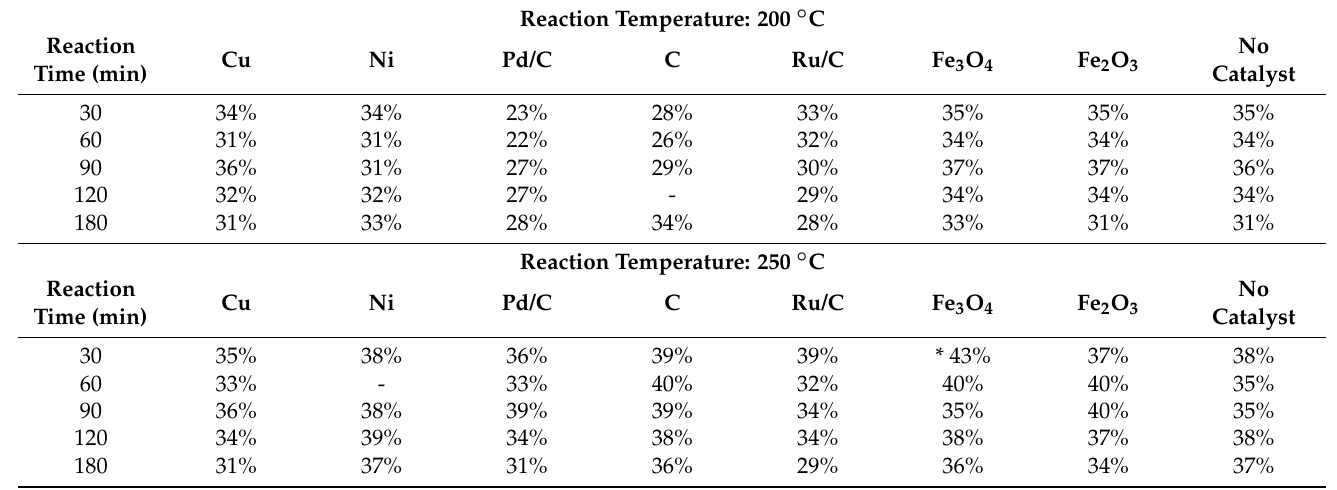
Table 3. Yields of lactic acid obtained after the hydrothermal reaction of NaHCO 3 with glucose in the presence of catalysts. The higher yields obtained after the hydrothermal reactions are marked with an asterisk (*).